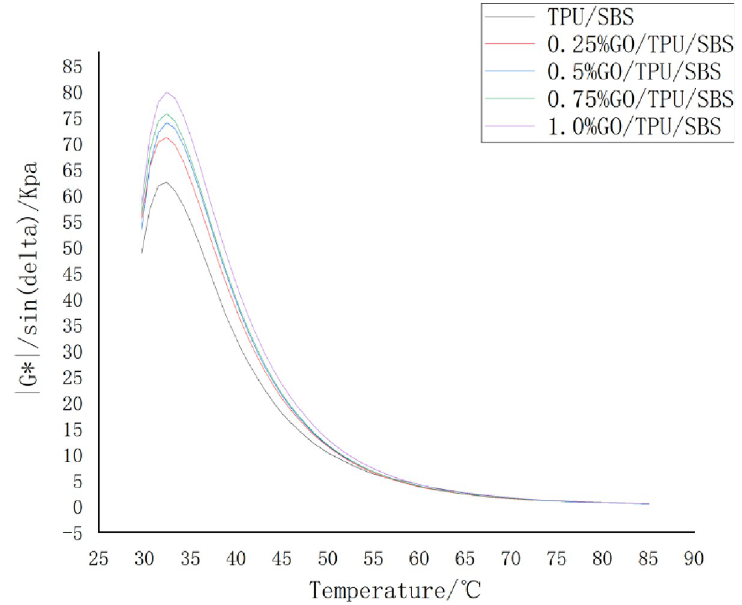
Fig 7. The variation of the rutting factor of GO/TPU/SBS-modified asphalt with the temperature.